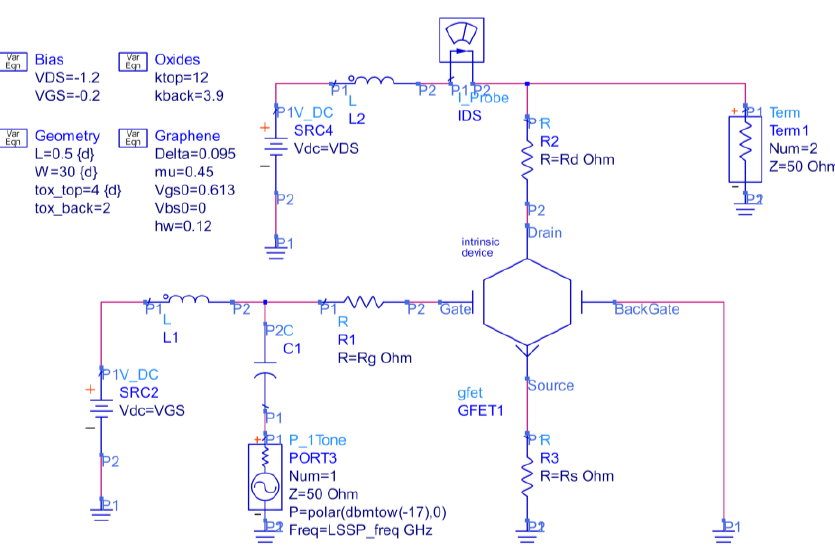
Figure 1. Schematic for the GFET amplifier large-signal S -parameters (LSSP) analysis.